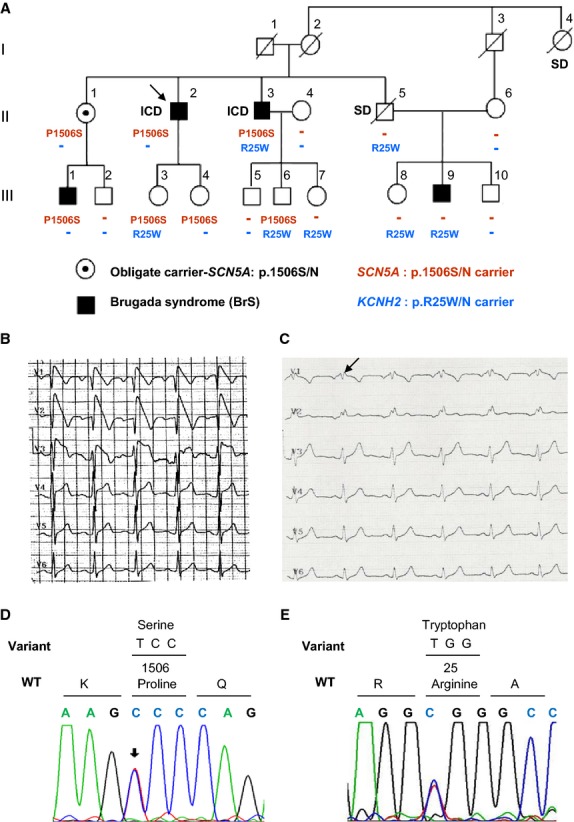
(A) The pedigree, phenotypes, and mutation status of family members. Males and females are indicated by squares and circles, respectively. The arrow shows the proband. SD: sudden death. ICD: implantable cardioverter defibrillator. (B) Representative 6‐lead (V1–V6) surface ECG of the proband showing a typical Brugada syndrome (BrS) pattern. (C) Representative 6‐lead surface ECG of the III.9 individual with a BrS type 2 pattern. (D) Chromatogram fragment of exon 26 of SCN5A gene. c.4516C>T heterozygote condition was shown by arrow and change the Proline to Serine in codon 1506 of SCN5A gene. (E) Chromatogram fragment of KCNH2 gene. c.73C>T heterozygote condition was shown by arrow and change the Arginine to Tryptophan in codon 25 of KCNH2 gene.